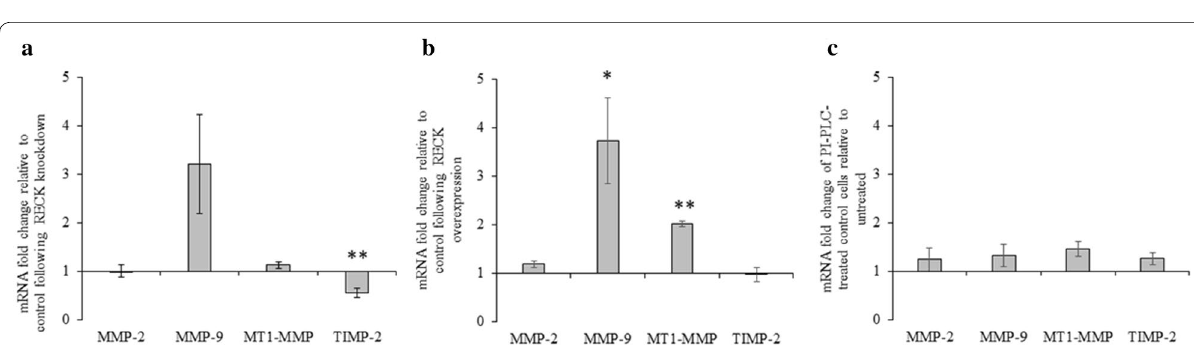
Fig. 7 Effect of RECK knockdown, RECK overexpression, and PI-PLC treatment on mRNA levels. The levels of MMP-2, MMP-9, MT1-MMP, and TIMP-2 mRNA were measured following RECK knockdown, overexpression, and PI-PLC treatment in A6 cells using real-time qPCR. a Following RECK reduction in cells, MMP-2, -9, and MT1-MMP levels did not change significantly compared to control; however, TIMP-2 levels decreased significantly. b Following RECK overexpression, MMP-2 and TIMP-2 mRNA levels did not change significantly, however, MMP-9 and MT1-MMP mRNA levels increased significantly compared to control. c Treatment of cells with PI-PLC did not change MMP-2, -9, MT1-MMP, or TIMP-2 mRNA levels. Changes in gene expression were measured relative to EF1α and normalized to control cells (set to 1). Results are based on 3 biological replicates (mean SEM; technical replicates, N 9). Data is analyzed via t-test; *, p 0.05; **, p ± = ≤ ≤